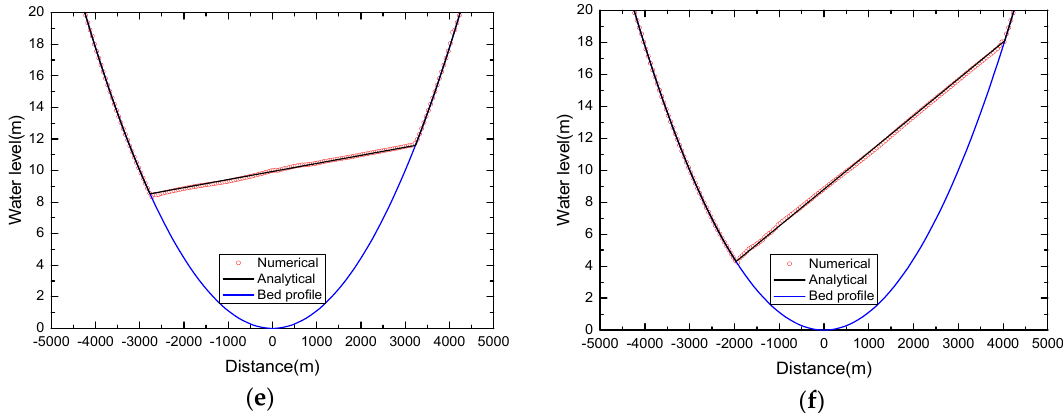
Figure 18. Wetting and drying over a parabolic topography; the water level at different times: ( a ) t = 1000 s; ( b ) t = 2000 s; ( c ) t = 3000 s; ( d ) t = 4000 s; ( e ) t = 5000 s; ( f ) t = 6000 s.